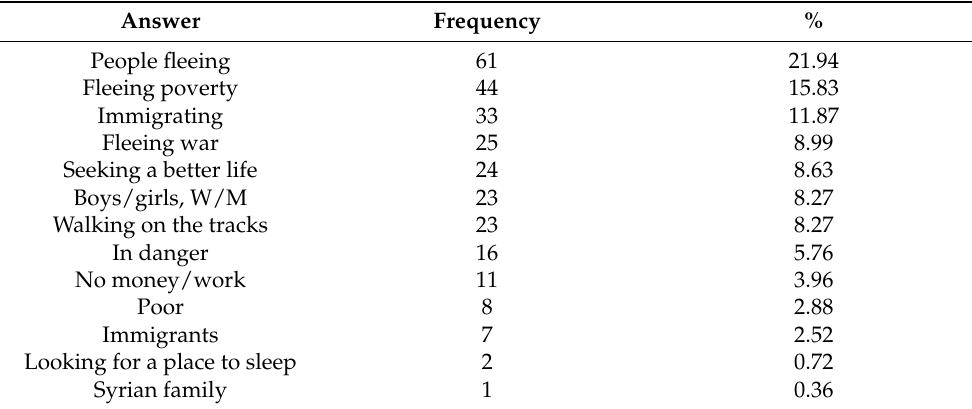
Table 3. Social representations from Figure 3 (Refugees).